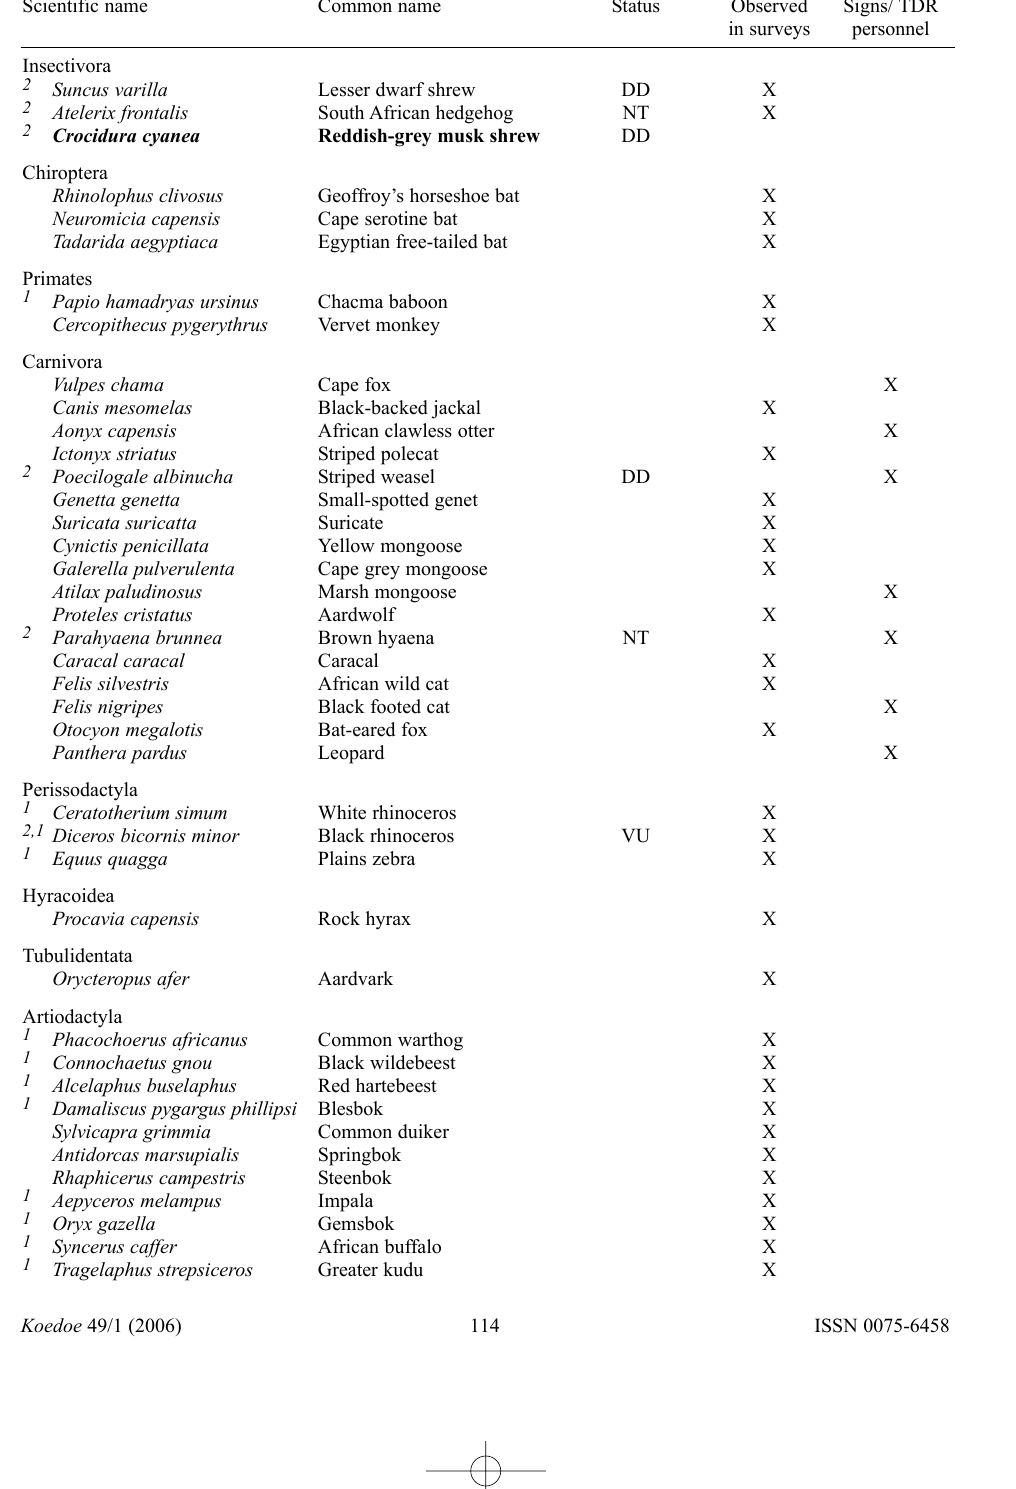
Table 1 Mammals recorded in Tussen-die-Riviere 1 = Re-introduced, 2 = Listed Red Data species (Friedman & Daly 2004). 3 = Exotic. DD = Data Deficient; NT = Near Threatened; VU =